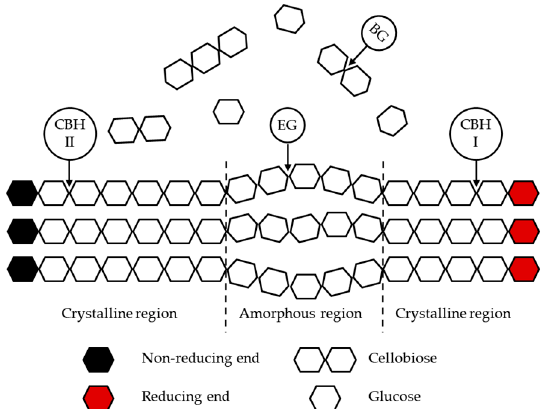
Figure 2. Schematic representation of the enzymatic hydrolysis of cellulose.